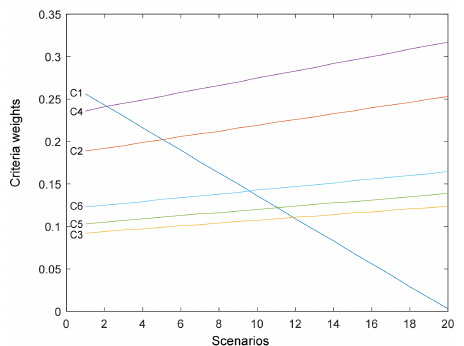
Figure 4. Values of weight coefficients through 20